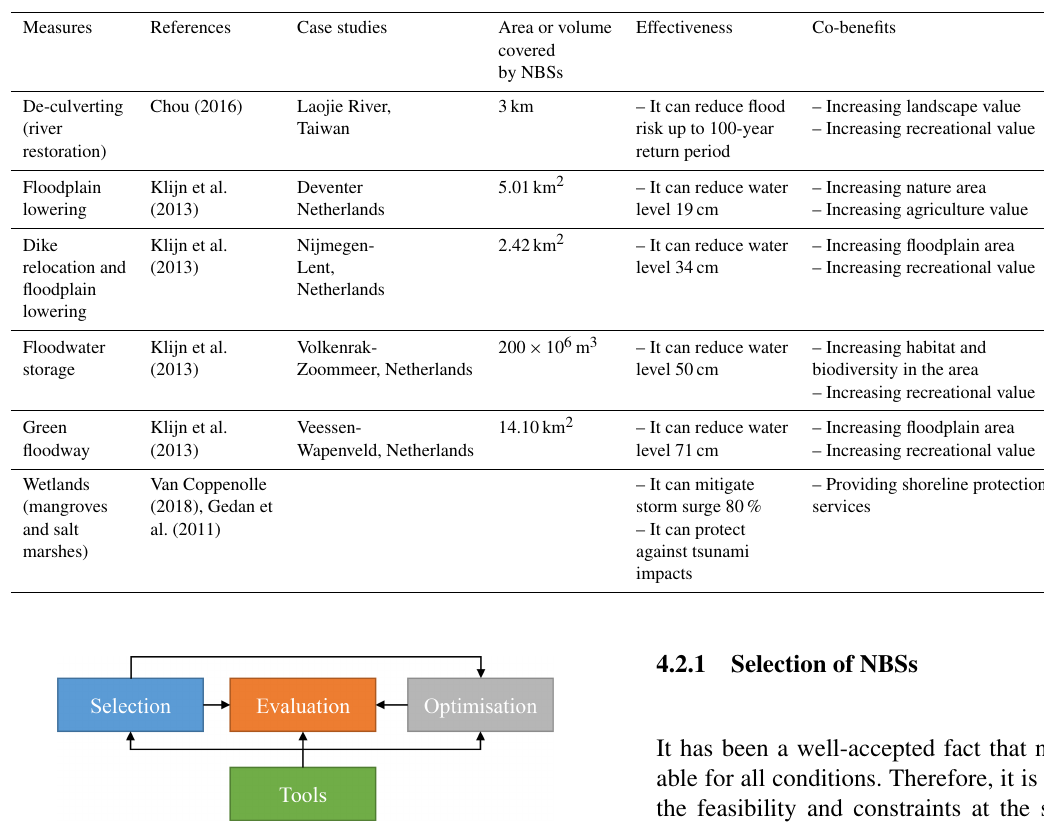
Table 4. Summary of effectiveness, co-benefits and costs of large-scale NBS measures.